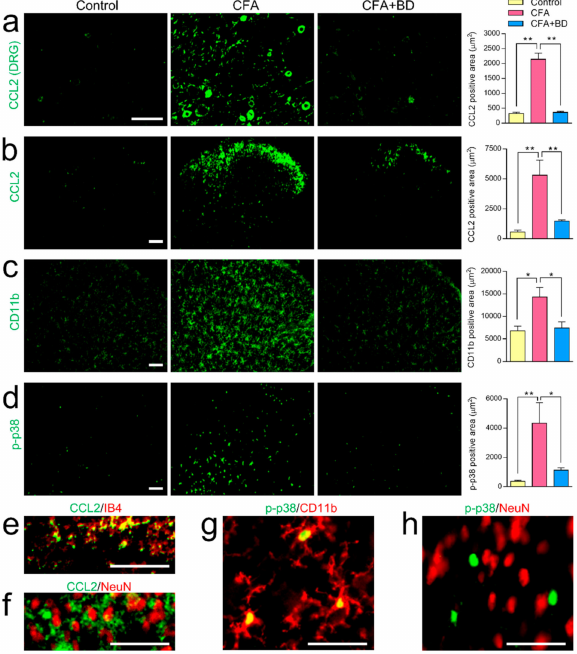
Figure 4. The effect of BD1047 (BD) on complete Freund’s adjuvant (CFA)-evoked CCL2 elevation and microglial activation. On the 7th day after CFA injection CCL2 expression was significantly higher in both DRG ( a ) and spinal dorsal horn ( b ) than in non-inflamed control group. CCL2 expression was dramatically reduced by repeated BD administration. CFA-induced inflammation produced a marked increase in the amount of CD11b ( c ) and phosphorylated p38 mitogen-activated protein kinases (p-p38, ( d ) present in the spinal dorsal horn. These increases were also dramatically inhibited by repeated treatment of BD. * p < 0.05, ** p < 0.01; Tukey’s multiple comparison test; three rats in each group; Scale bar = 100 µ m. Double-labeling study showing that CFA-induced CCL2 immunoreactivity in lamina I-II spinal cord predominantly overlapped with IB4 ( e ) but not with NeuN ( f ). CFA-induced p-p38 immunoreactivity in the spinal dorsal horn was exclusively co-localized with microglia (CD11b, ( g )) but not with neurons (NeuN, ( h )). Scale bar = 50 µ m.